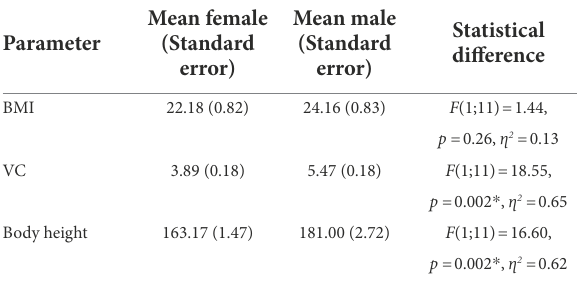
TABLE 4 Mean female and male body-mass-index (BMI), vital capacity (VC) and body height including standard error and the results of analysis of statistical differences (significant differences are marked in darker